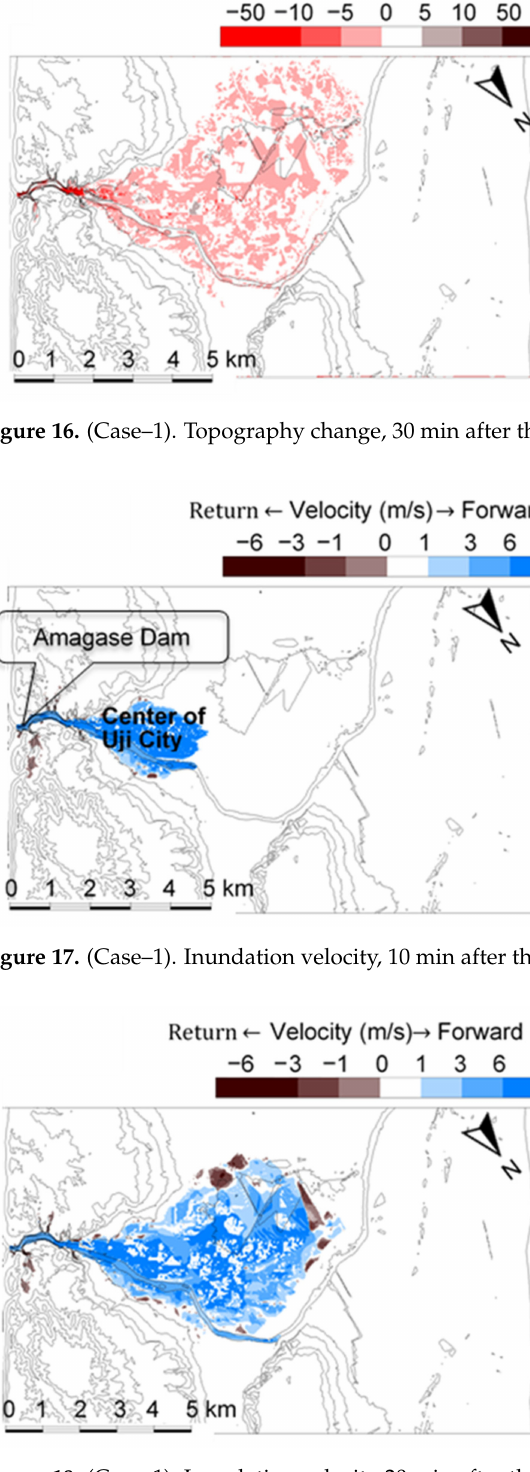
Figure 18. (Case–1). Inundation velocity 20 min after the start of the